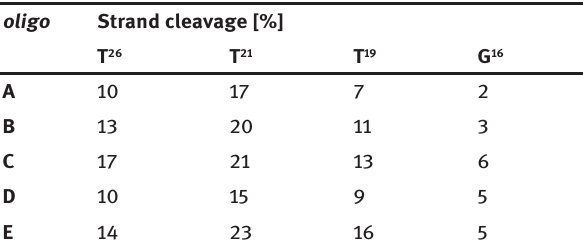
of UVA irradiation in the A-E oligonucleotides investigated under densitometry of the autoradiogram presented in Fig. 3.